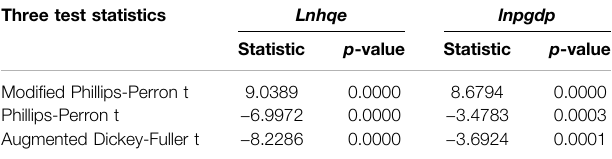
TABLE 5 | The results of the cointegration